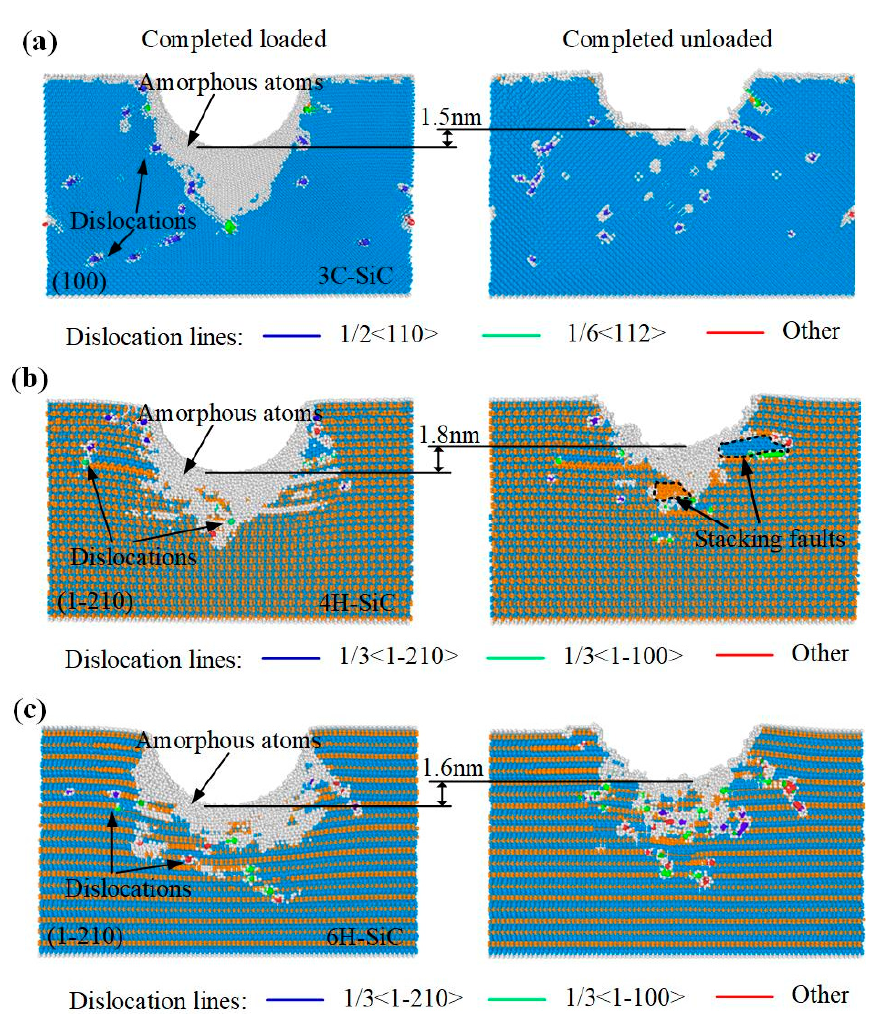
Figure 3. Cross-sectional view of nanoindentation for three types of SiC single crystal at completed load and completed unload. ( a ) (100) plane in 3C-SiC, ( b ) (1-210) plane in 4H-SiC, and ( c ) (1-210) plane in 6H-SiC, respectively.